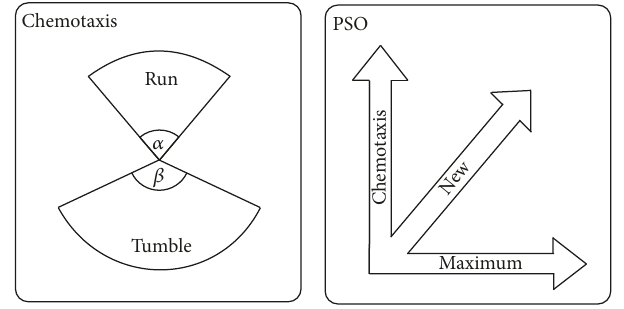
Figure 4: PdUC algorithm: calculation of a new direction.